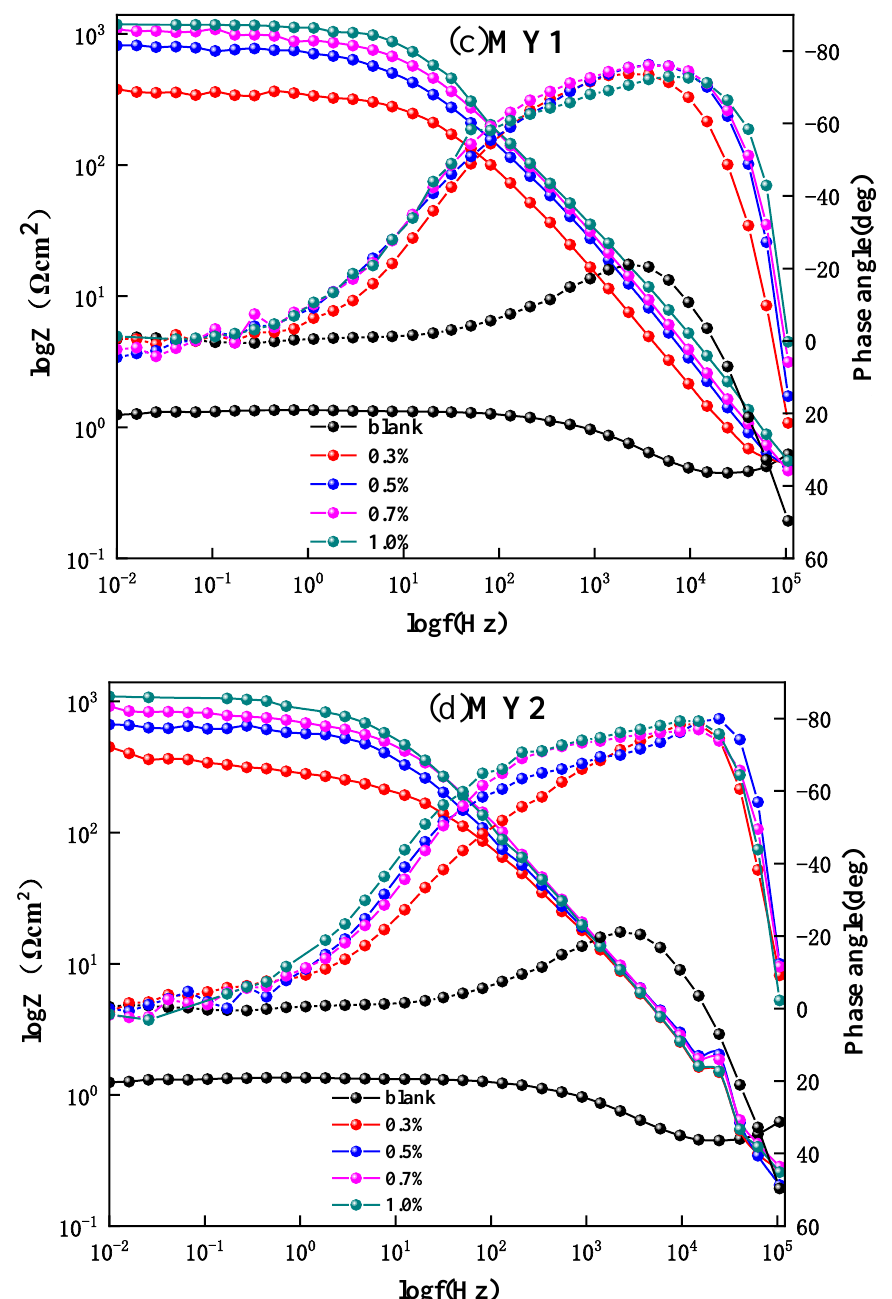
Figure 4. EIS plots (( a , b ) are Nyquist plots of MY1 and MY2, ( c , d ) are Bode plots of MY1 and MY2).